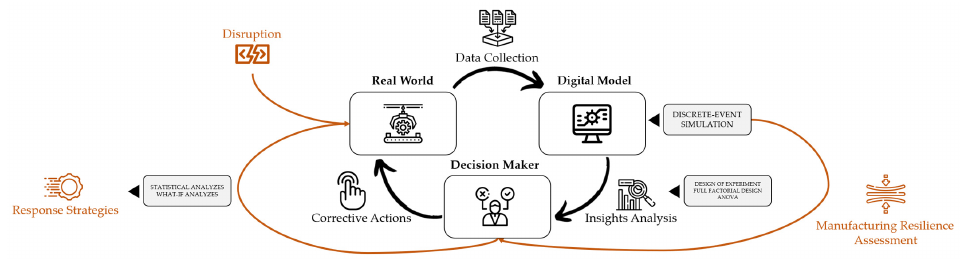
Figure 1. The simulation-based framework for manufacturing design and resilience